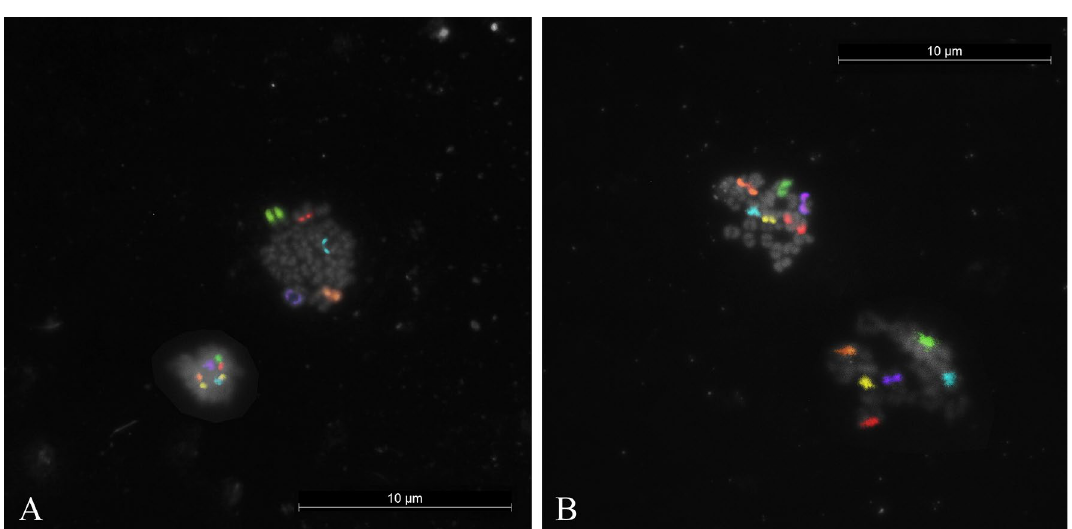
Figure 5. Metaphases and corresponding first polar bodies of in vitro-matured secondary oocytes of swamp buffalo after multicolour FISH showing ( A ) nullisomy for chromosome 5 (MII,24,X,-5) (yellow); ( B ) PSSC for chromosome X (MII,24,X,−X,+Xcht,+Xcht)